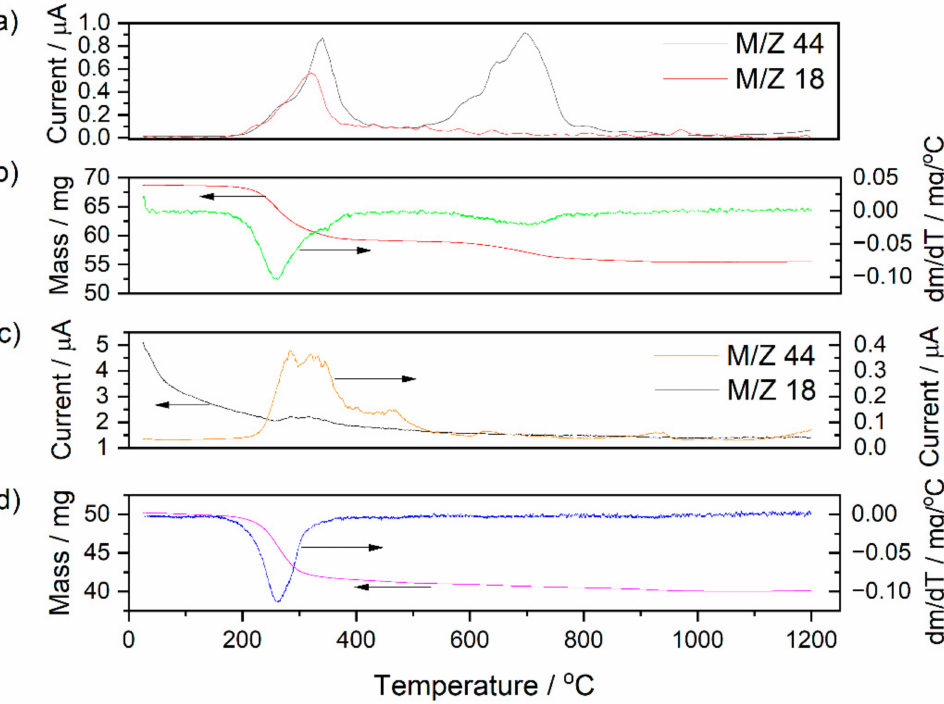
Figure 5. ( a – d ) Juxtaposition of recorded variations in the intensity of CO 2 (M/Z 44) and H 2 O (M/Z 18) in evolving gaseous products during 5CBCY and NiO–5CBCY heating in